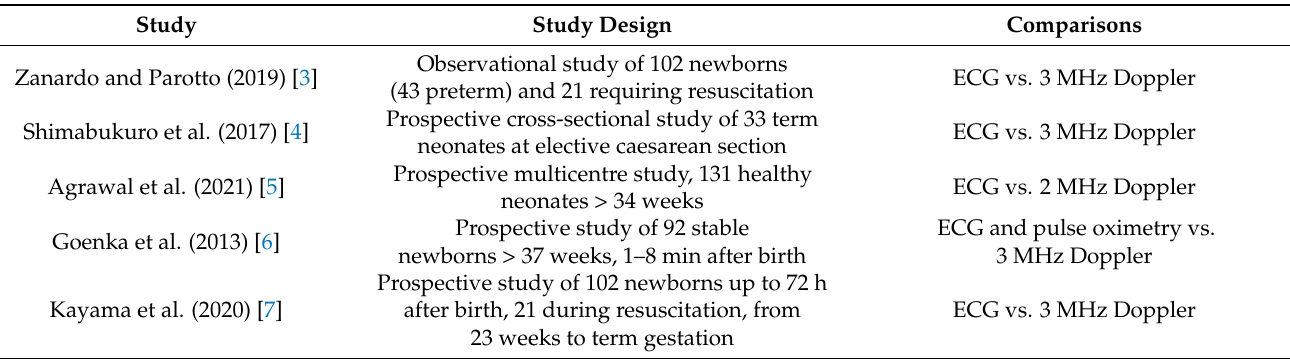
Table 1. Human studies included in the